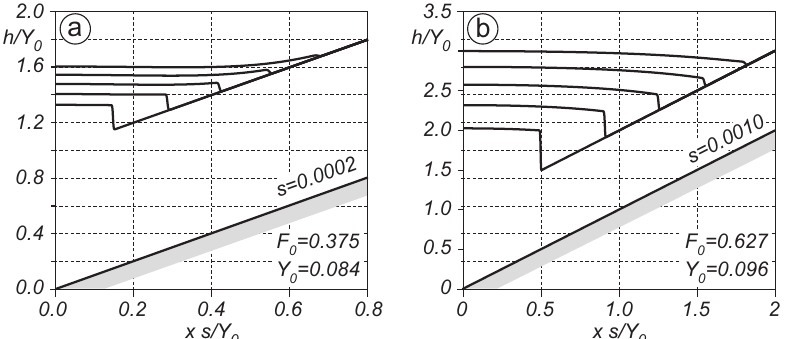
Figure 8. Free surface profiles at different times, t/ τ , after sluice gate closure; ( a ) t/ τ = 0.16, 0.32, 0.48, 0.64, 0.80 (run 3); ( b ) t/ τ = 0.61, 1.21, 1.82, 2.43, 3.03 (run 24). h / Y 0 is the non-dimensional free surface elevation and xs / Y 0 is the non-dimensional coordinate in the flow direction, positive